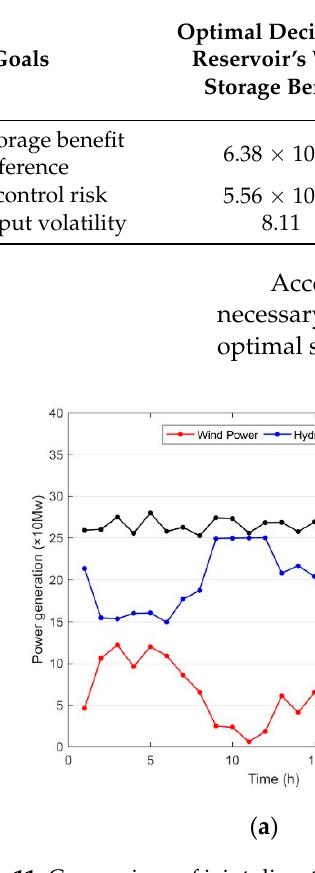
Figure 11. Comparison of joint dispatching results. ( a ) Joint dispatch of hydropower and wind power based on hedging theory; ( b ) Conventional hydropower and wind power joint dispatch.